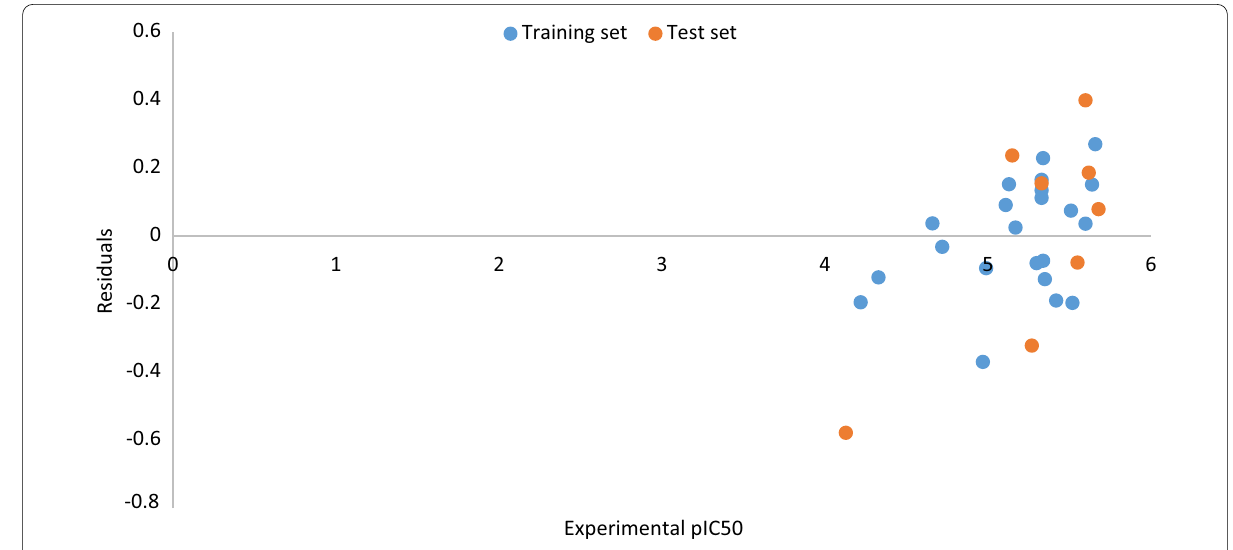
Fig. 2 Plot of residuals versus actual pIC 50 values for modelling and validation sets